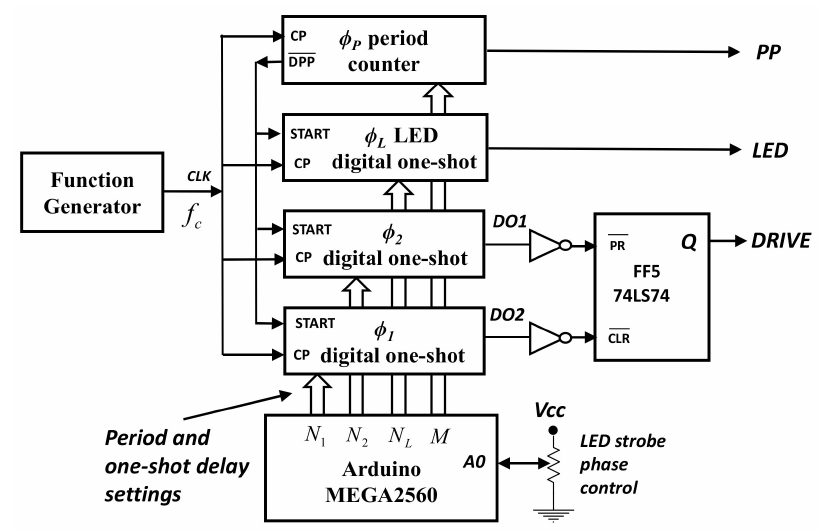
Figure 3. Schematic diagram of the timer circuit showing the generation of the output pulses using the digital delay modules.